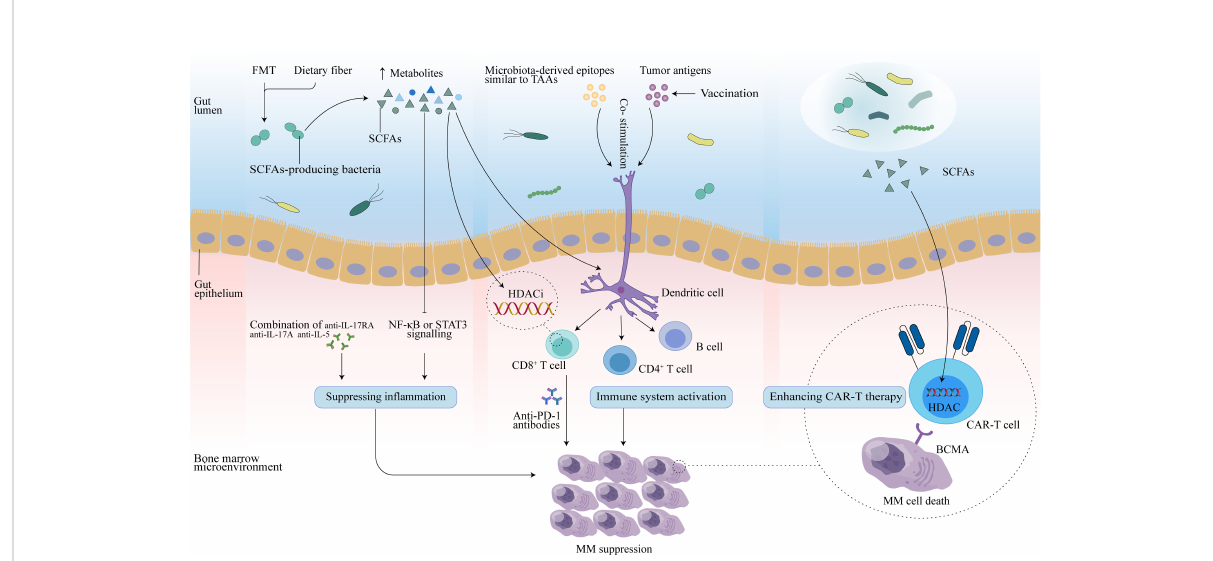
FIGURE 2 Potential therapeutic effects of the gut microbiota in MM. FMT may reconstruct the gut microbiota, and dietary fi ber may increase levels of SCFAs secreted by SCFAs-producing microbiota. Butyrate in SCFAs may promote CD8 + T function by inhibiting HDAC, and activated CD8 + T cells combined with anti-PD-1 antibodies may enhance anti-myeloma effects. In addition, SCFAs can slow MM progression by inhibiting Th17 cells, and further reducing in fl ammatory cytokines (IL-17 and IL-6) that promote MM progression. Combination therapy with anti-IL-17RA, anti-IL-17A, and anti-IL-5 may also mediate antitumor effect. Vaccination controls tumor growth by activating T- and B-cell-mediated immunity through activation of the antigen-presenting capacity of DCs, thereby inducing an immune response against tumor antigens in the host. Microbial epitopes similar to tumor-associated-antigens (TAAs) may interact with DCs to enhance the vaccine response. Additionally, SCFAs may also enhance anti-tumor activity by reprogramming CAR-T cells through